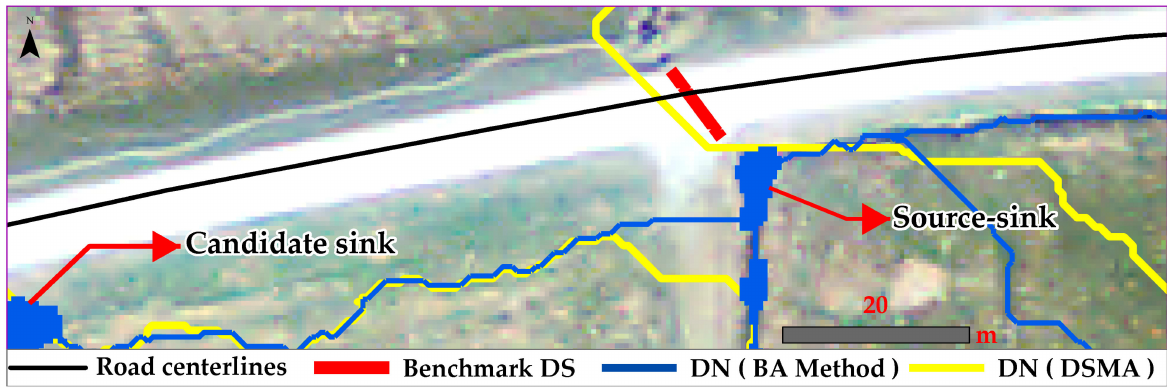
Figure 8. DSs resolved correctly (TP, yellow line) by DSMA-based DS data compared with the BA method (FN, blue line).